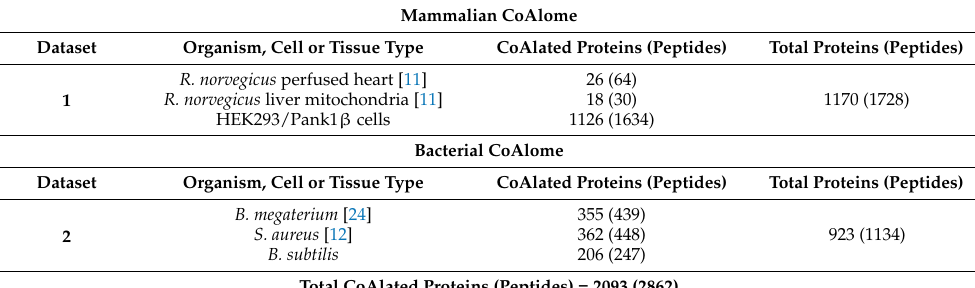
Table 1. Summary of currently available mammalian and bacterial CoAlated protein datasets. The organism, cell or tissue type, and the number of total CoAlated proteins (peptides) for each of the mammalian and bacterial smaller datasets are shown. CoAlated protein isoforms were removed in order to calculate the total number of unique CoAlated proteins for each of the mammalian and bacterial